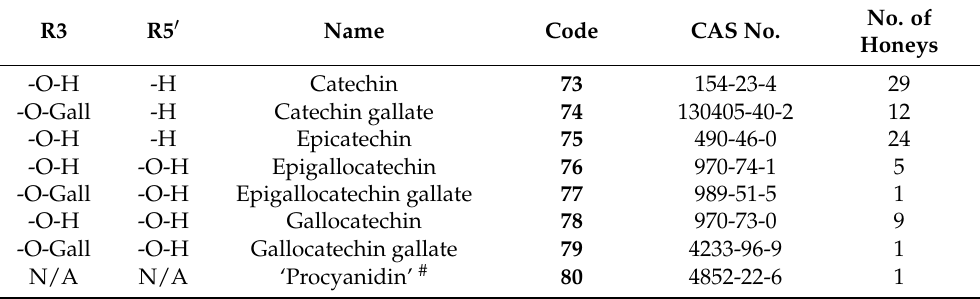
Table 6. Flavan-3-ols reported in monofloral honeys (see Figure 1 for general